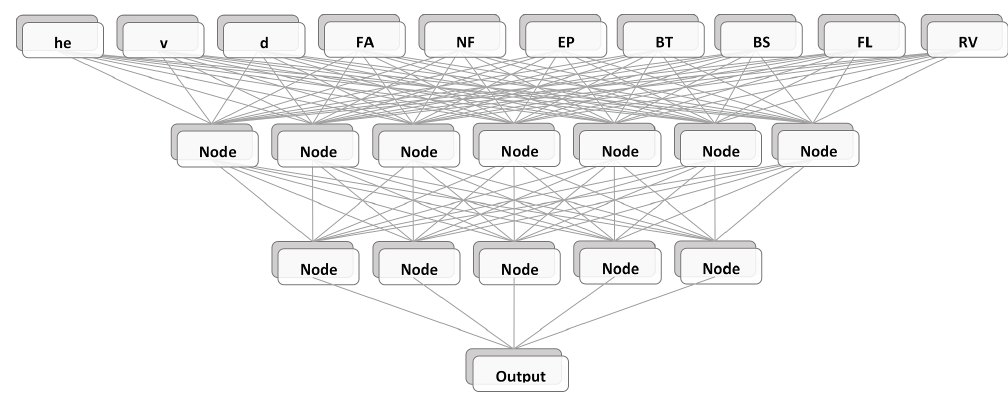
Figure 4. Structure of the artificial neural network model applied in this study by using two neuron (node)